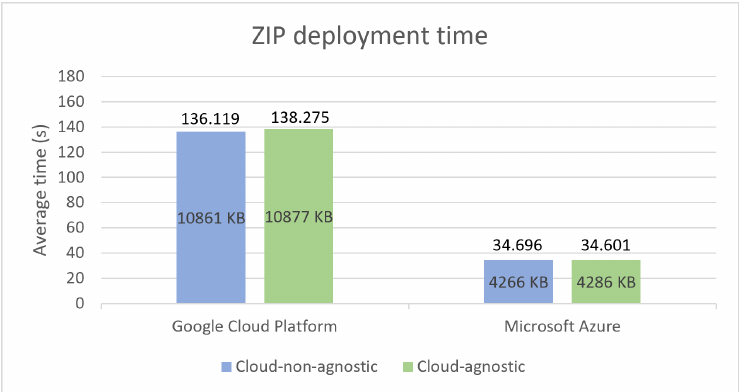
Figure 17. ZIP deployment